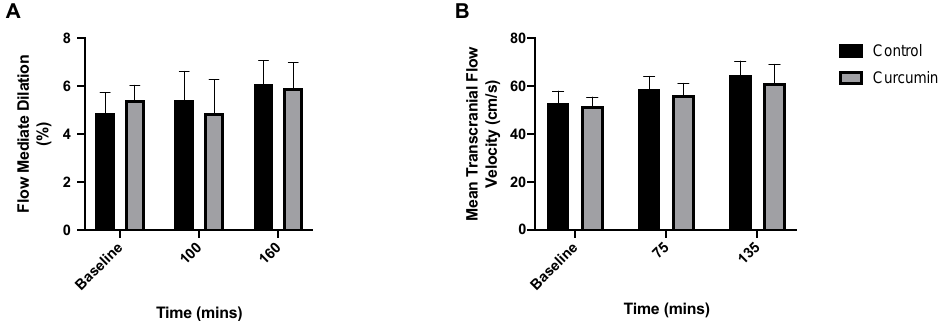
Figure 4. The impact of curcumin alongside oral nutritional supplement feeding on ( A ) flow-mediated dilation ( n = 8 per condition) and ( B ) transcranial blood flow ( n = 11 per condition) in healthy older adults.